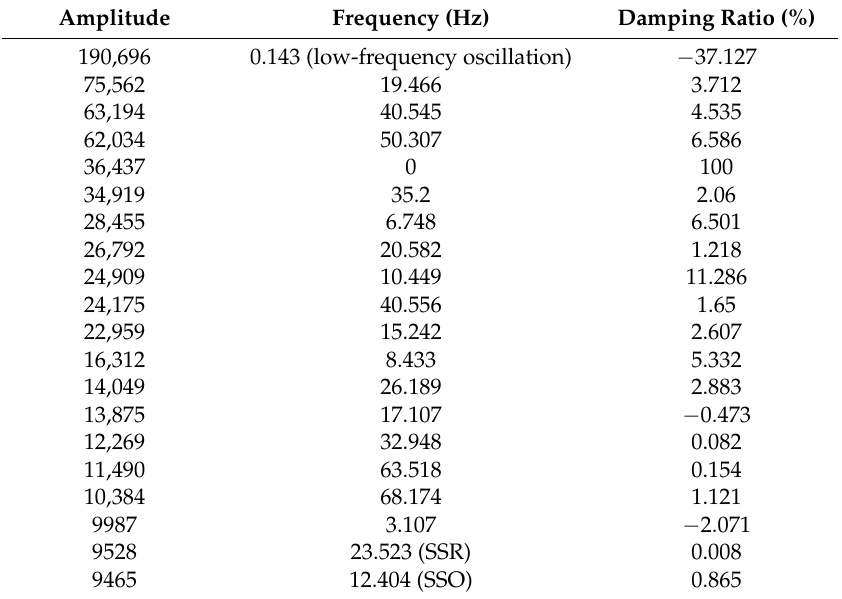
Table 2. Results of the Prony analysis.